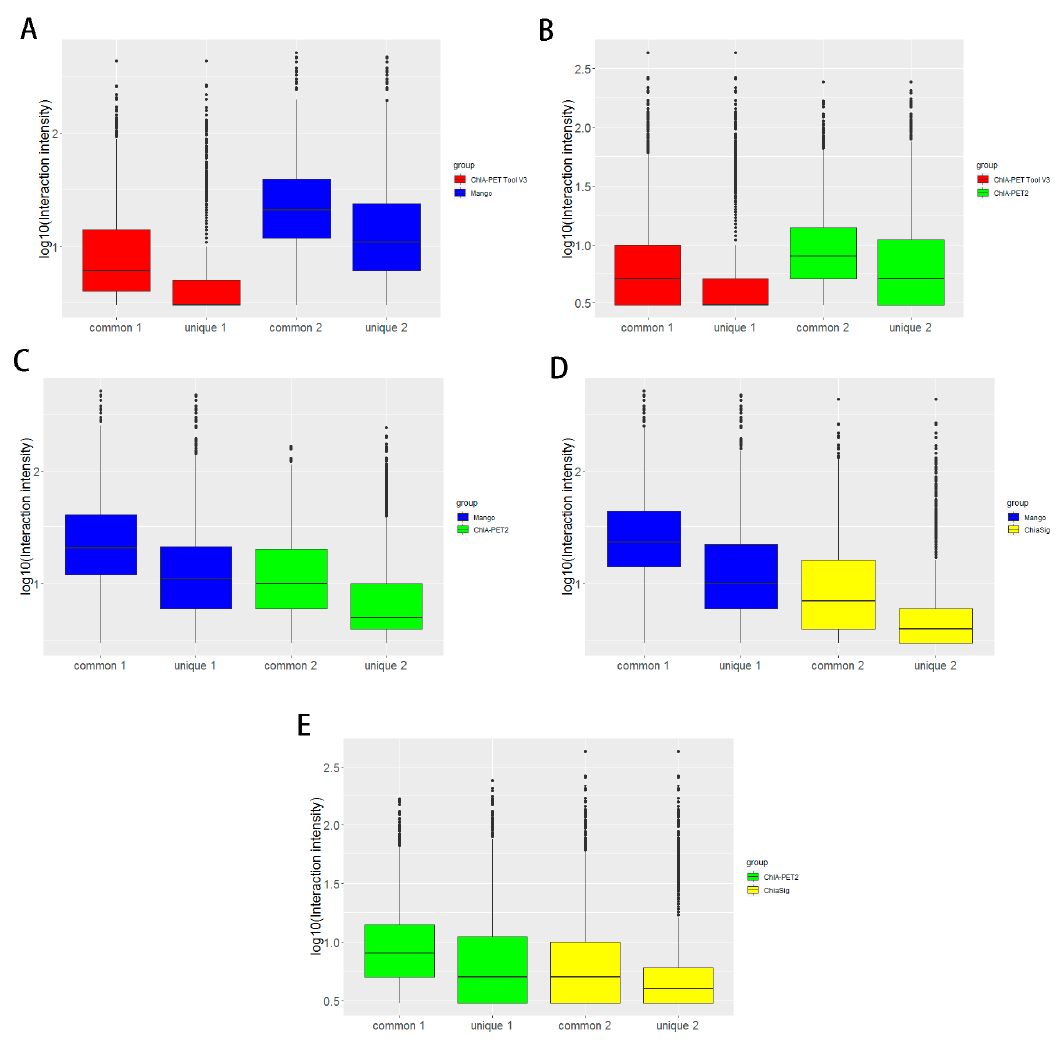
Figure 15. Box plots of interaction intensity between different tools from human K562 cells. ( A ) Interaction intensity between ChIA-PET Tool V3 and Mango. ( B ) Interaction intensity between ChIA-PET Tool V3 and ChIA-PET2. ( C ) Interaction intensity between Mango and ChIA-PET2. ( D ) Interaction intensity between Mango and ChiaSig. ( E ) Interaction intensity between ChIA-PET2 and ChiaSig.